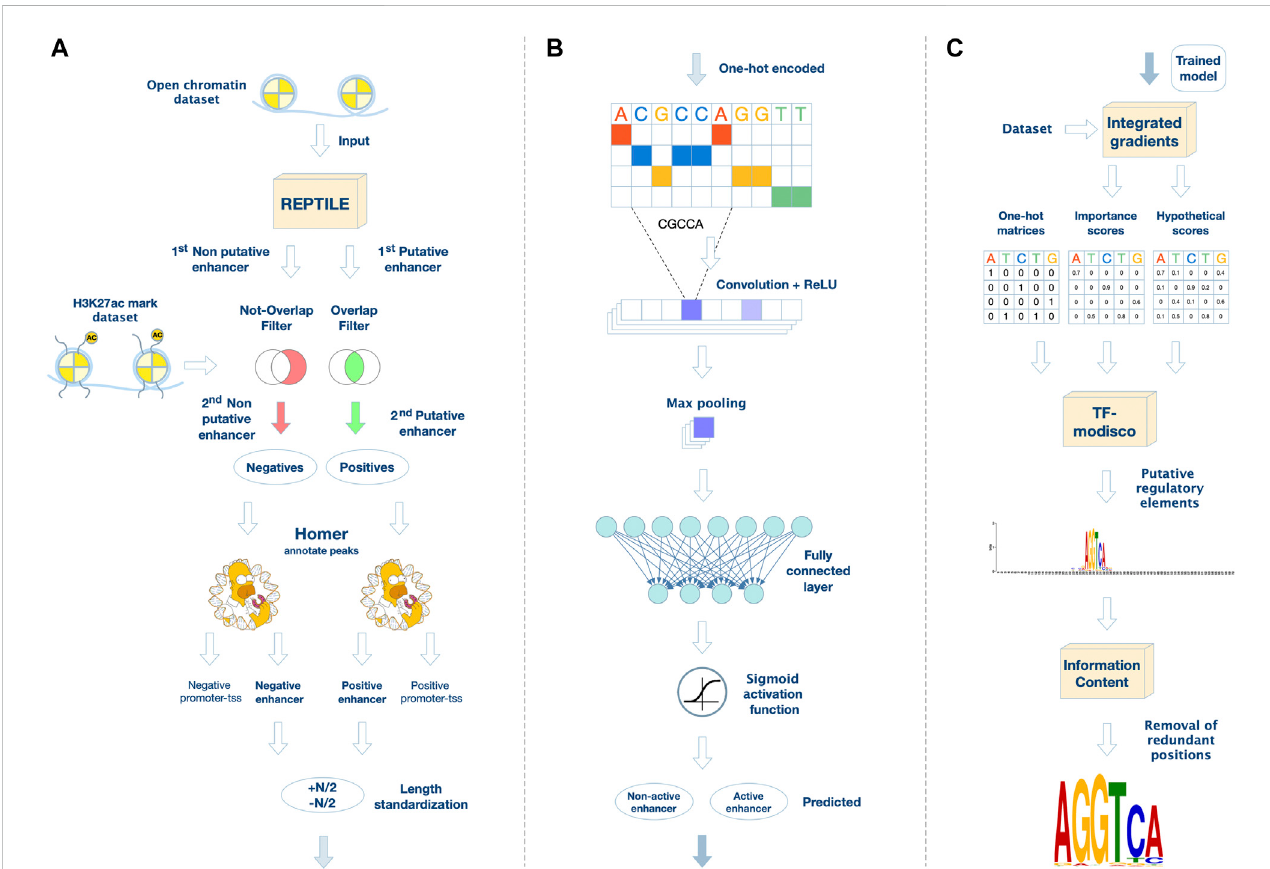
FIGURE 2 A novel framework for analyzing regulatory elements and their corresponding de novo transcription factor motifs. (A) Data preprocessing and fi ltering. We extracted putative regulatory elements from open-chromatin regions using REPTILE. Then, we generated the positive set of active enhancer regions by fi ltering out regions that do not overlap a H3K27ac peak in our dataset. In parallel, we generated the negative set by excluding open-chromatin regions that overlap a H3K27ac peak in our datasets. Moreover, sequences annotated by HOMER as promoter-TSS were excluded from both positive and negative sets. (B) CNN for active enhancer classi fi cation. The positive and negative DNA sequences are one-hot encoded as a pre-processing step to the network. In theconvolutionallayer,includinganon-linearactivationfunction,the fi ltersareappliedontheinputmatrix.Then,amax-poolinglayerscanstheoutputvector (the purple rectangle denotes the maximum value in each vector). Last, a fully connected layer models interactions, followed by an output neuron, which applies the sigmoid activation function for binary classi fi cation. (C) Motif extraction. We used the Integrated Gradients approach to highlight important nucleotidesineachsequence.Then, weappliedTF-MoDISco toaggregate these results to alist of putative motifs inPWM format. Redundantpositionsofthe motifs were removed using an information-content